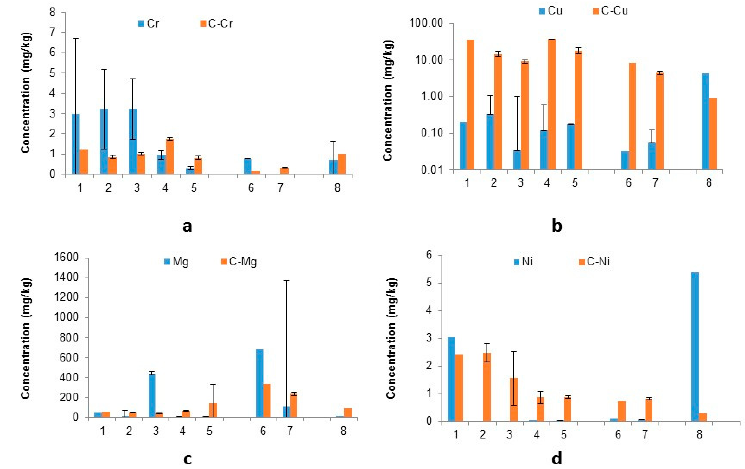
Figure 4. Concentration of ( a ) Cr, ( b ) Cu, ( c ) Mg and ( d ) Ni (mg/kg) in solution after water and citric acid leach (C-Element refers to citrate leached results). (Samples: ESP dust: 1–5, BF sludge: 6–7, BOF sludge: 8)